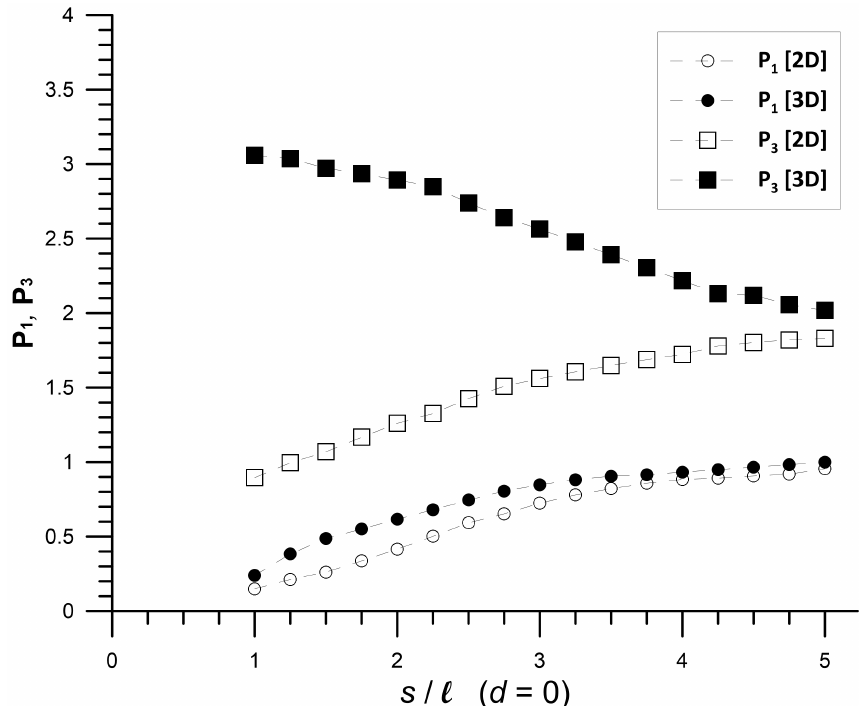
Figure 8. Trend of the inversion effectiveness parameters P 1 and P 3 referring to the 2D ERT (white squares and circles) and central sections of the 3D ERT (black squares and circles) crossing over prism-shaped models shown in Figures 2 and 3 as the s / l ratio between the orthogonal width s of the prism and the side of its square section l